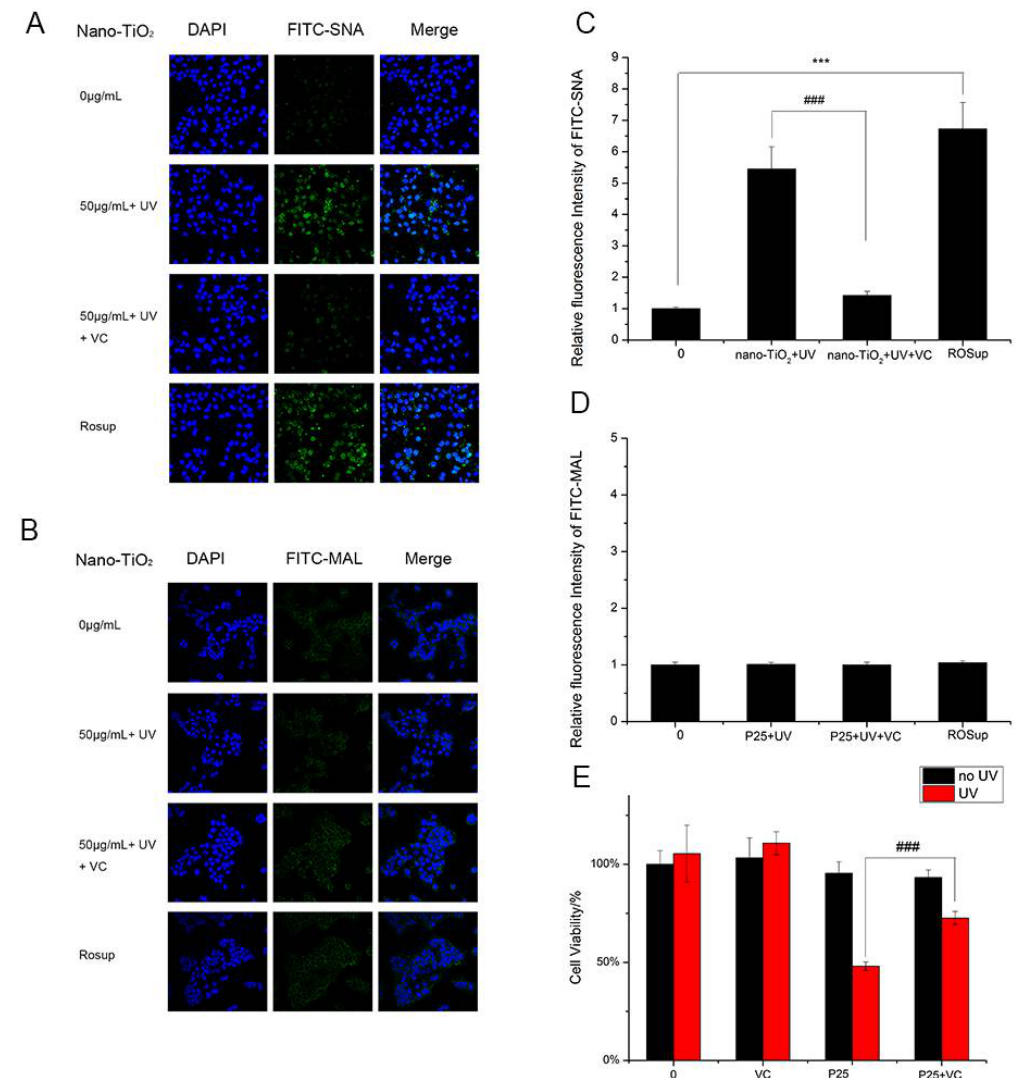
Figure 7. Detection of changes in sialic acids by lectin staining. HaCaT cells were treated with 50 µ g/mL nano-TiO 2 P25 and UV, the combination of 1 mM VC, nano-TiO 2 P25 and UV, or 50 µ g/mL ROSup. Staining was performed with FITC-labeled ( A ) SNA for α -2,6 sialic acid residues (green), ( B ) MAL for α -2,3 sialic acid residues (green), and DAPI for nuclei (blue). The bar graphs show the fluorescence intensity analysis for ( C ) A and ( D ) B (error bars are standard error of the mean). ( E ) The effects of vitamin C (VC) on cell viability under treatment with nano-TiO 2 P25 and UV irradiation. Significant differences are indicated where ( n = 5) ± SEM, *** p < 0.001, ### p < 0.001, compared with the same concentration of nano-TiO 2 in the presence of UV without VC treatment.